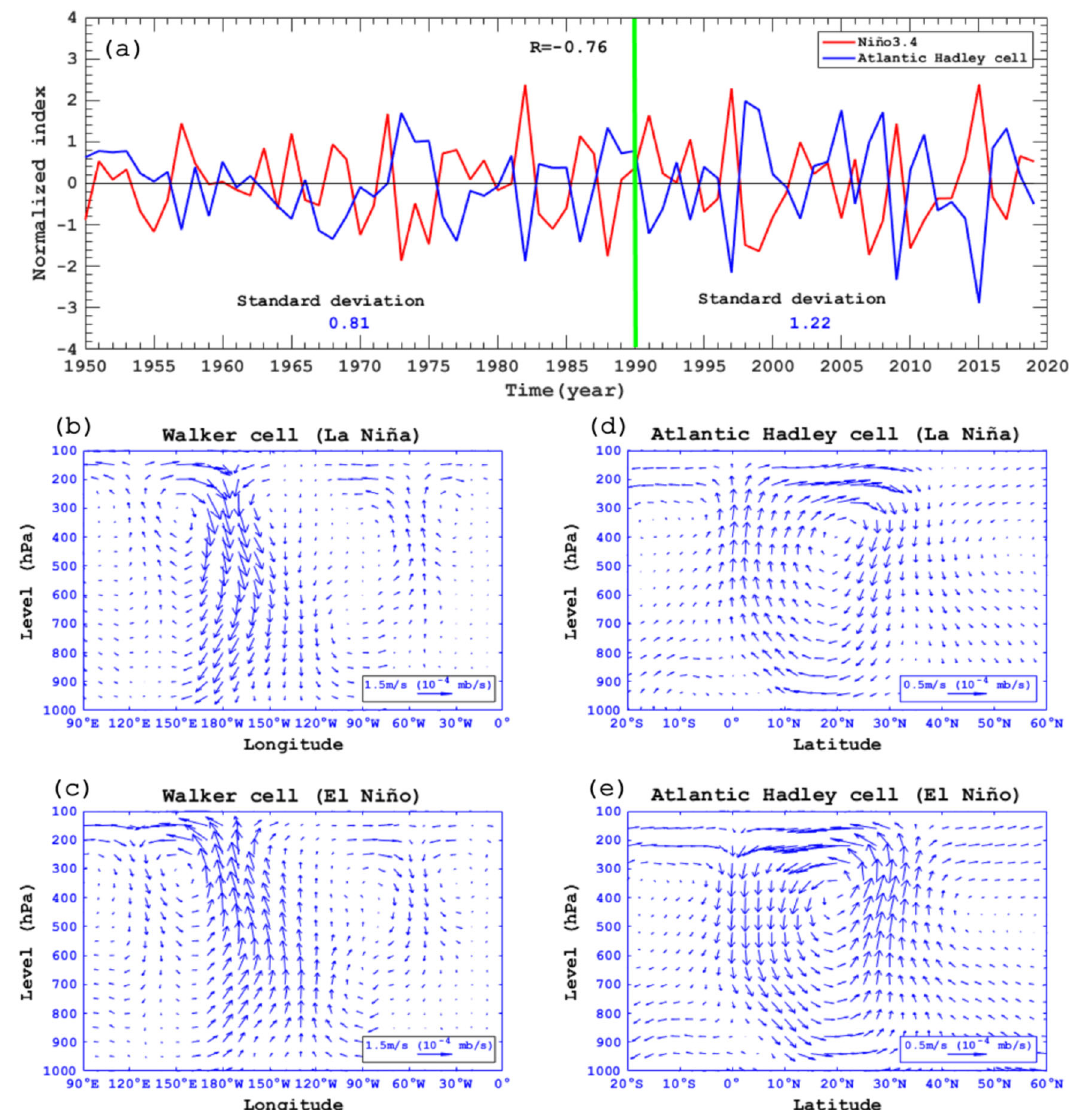
Fig. 7 | Changes in the winter Walker cell and Atlantic Hadley cell with El Niño and La Niña. a Time series of normalized DJF (December-February) mean Niño3.4 (red line) and Atlantic Hadley cell (blue line) indices during 1950 – 2019, where the Atlantic Hadley cell index is de fi ned as the difference of the domain-averaged DJF- mean 500-hPa vertical velocity between the subtropical North Atlantic (25° – 35°N, 80°W – 0°) and equatorial Atlantic (5°S – 5°N, 80°W – 0°). The correlation coef fi cient between the two lines is − 0.76 ( p <0.01) during 1950 – 2019. b , c Vertical-longitude